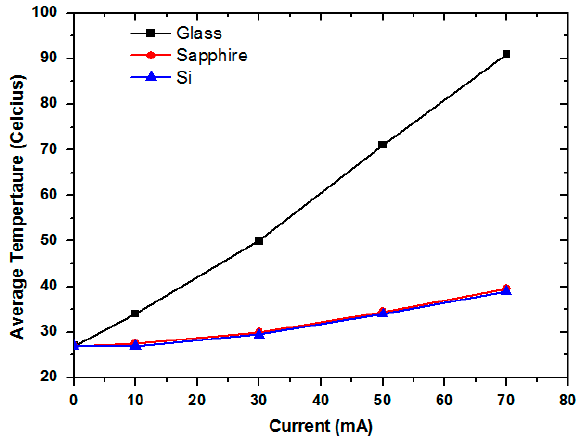
Figure 6. Average surface temperature vs . operation current for different submounts.